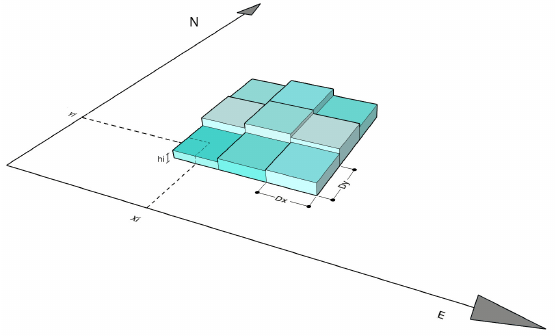
Figure 3. North and east coordinates of each pixel data and depth value ( x i , y i , h i ) of a flood map processed by the proposed